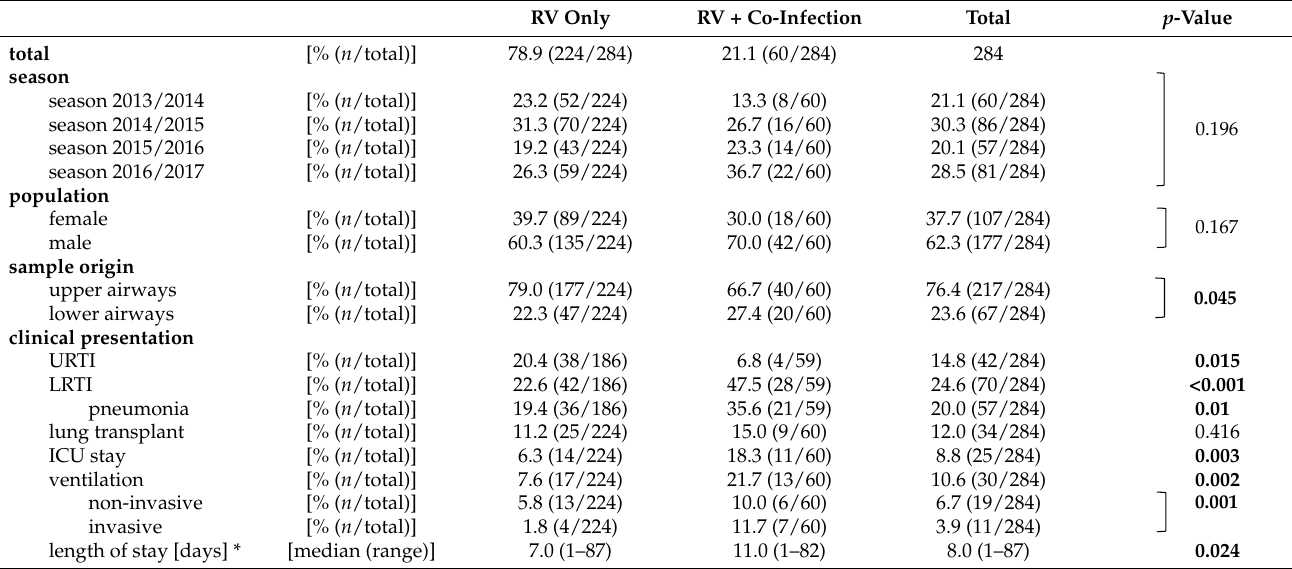
Table 4. Comparison of samples with and without co ‐ infections.